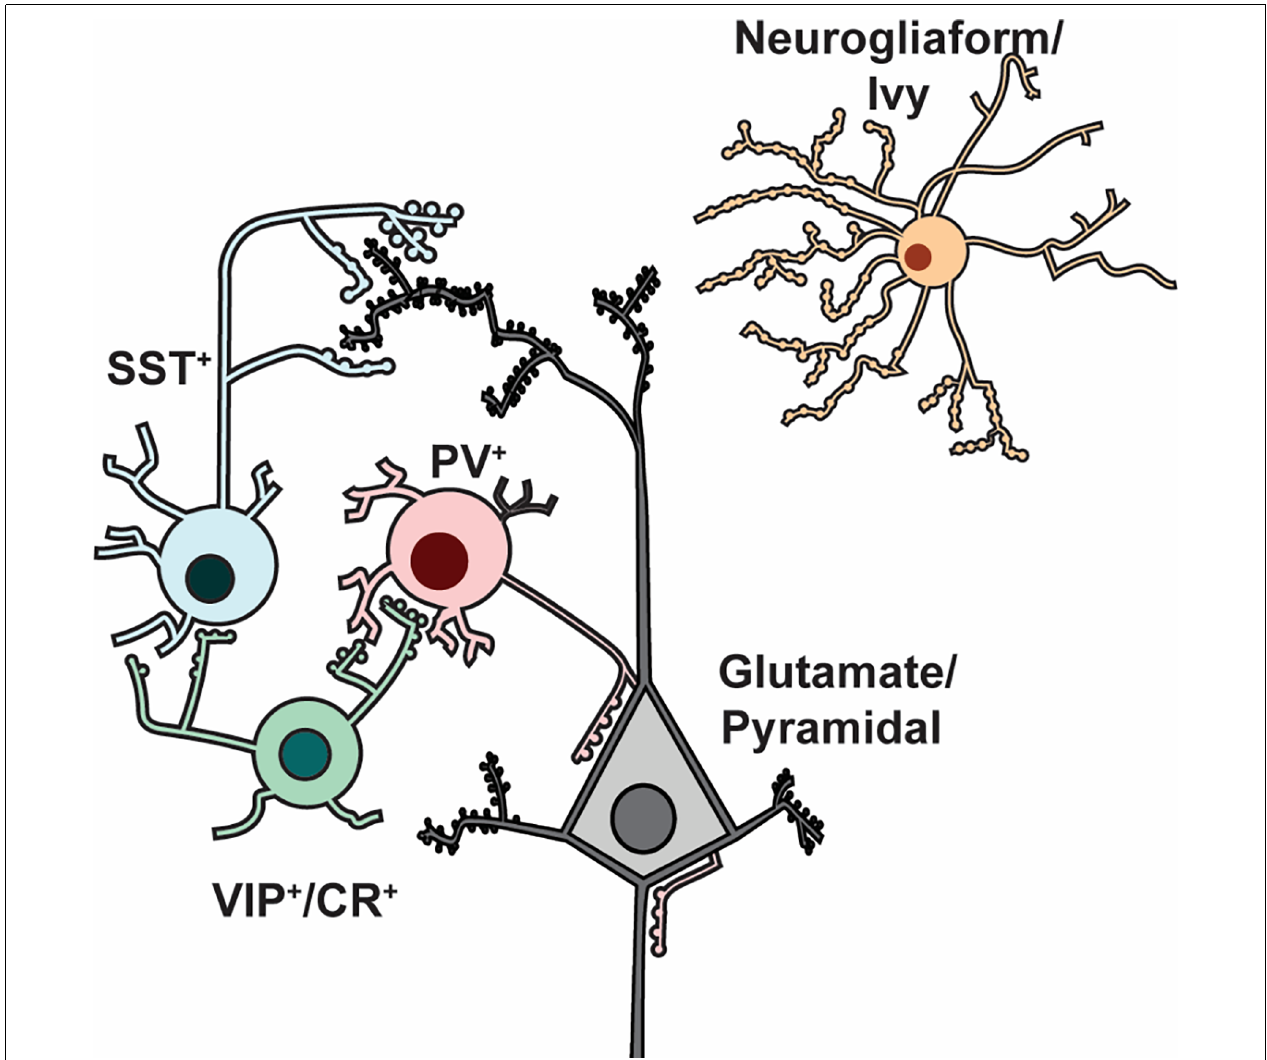
FIGURE 1 | Major interneuron subtypes. Cartoon illustration of prominent interneuron subtypes of the cortex and hippocampus, showing their stereotypical arrangements with each other and with glutamatergic/pyramidal neurons. PV + (parvalbumin-expressing) interneurons preferentially make axo-somatic and axo-axonic synapses onto glutamatergic pyramidal neurons, whereas SST + interneurons target pyramidal neuron dendrites. VIP + /CR + interneurons target PV + and SST + interneurons to disinhibit pyramidal neurons. Neurogliaform/ivy cell axons generally form a dense network of terminals that do not form classic synapses but instead release GABA volumetrically. This simplified diagram does not illustrate laminar distributions and morphology, which vary by region.